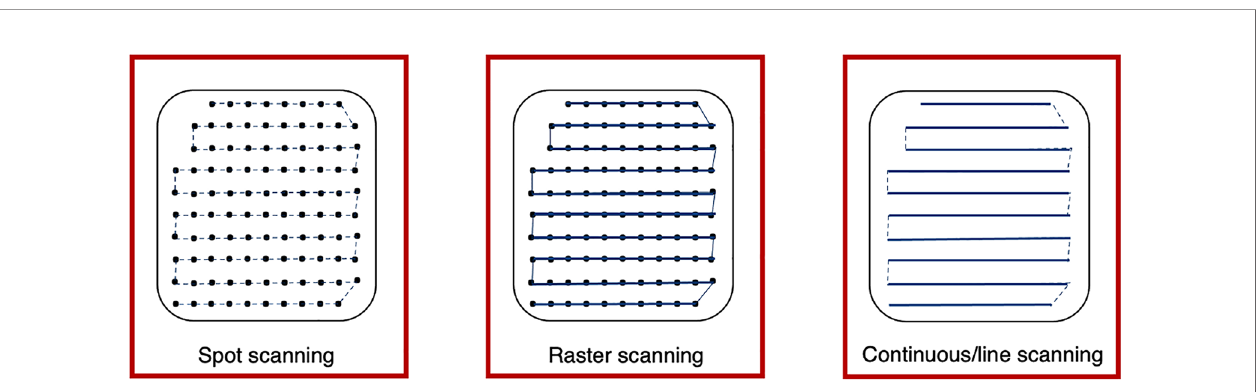
FIGURE 4 | Spot, raster and continuous line scanning patterns for PBS delivery. Spots and solid lines indicate beam-on irradiation and dashed lines indicate movement with beam-off. For spot scanning, the beam is turned off between movement to the next spot but remains on for the whole delivery in raster scanning. For continuous line scanning, the dose is delivered across a linear path (rather than as spots) and may be turned off between movement to subsequent